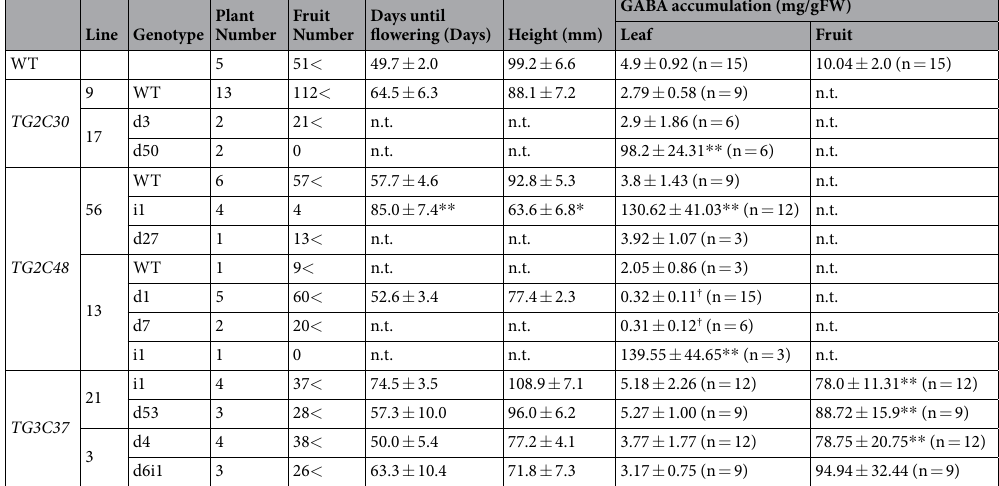
Table 4. Characterization of T 1 generation. Genotype of all plants in this table were homozygous. In “Genotype”, WT was same as wild-type sequence with no mutation detected. “d” and “i” means deletion and insertion, respectively. In column of “Days until flowering” and “Height”, data represent means ± SD, the repetition was same as plant number. GABA content data showed means ± SD (repetition). Asterisk and dagger indicated statistical differences in Tukey-Kramer’s test and Student’s t-test ( * P > 0.05, ** P > 0.01, † P > 0.01), respectively. “n.t.” was